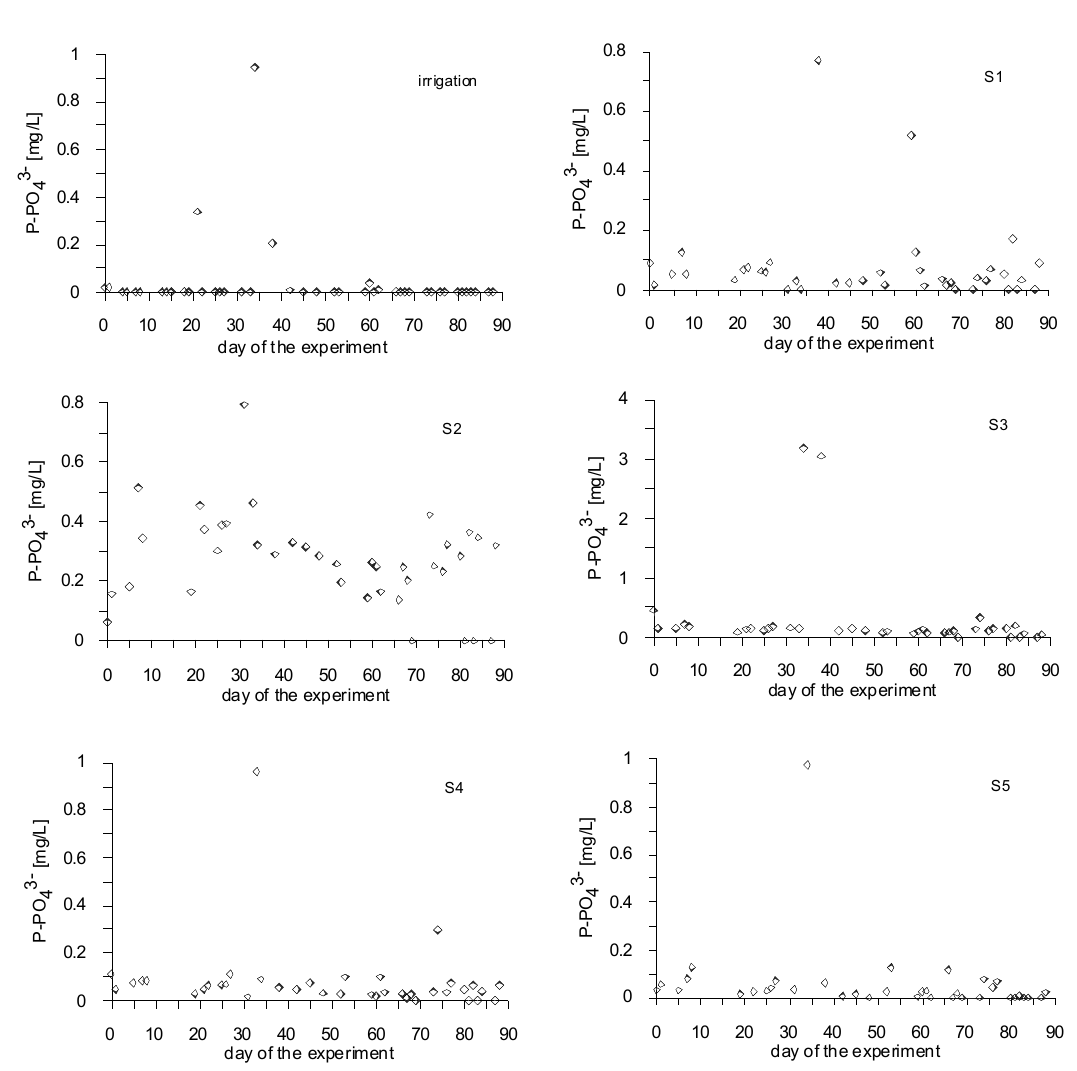
Figure 3. Concentrations of P-PO 43 − in simulated precipitation and leachates from substrates tested in the column experiment.